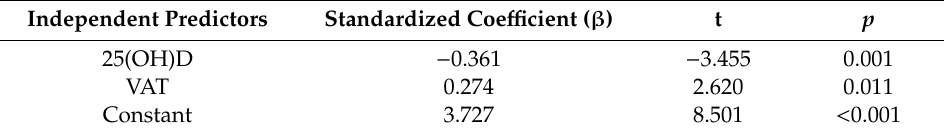
Table 7. Determinants of 1–84 PTH levels—stepwise multivariate